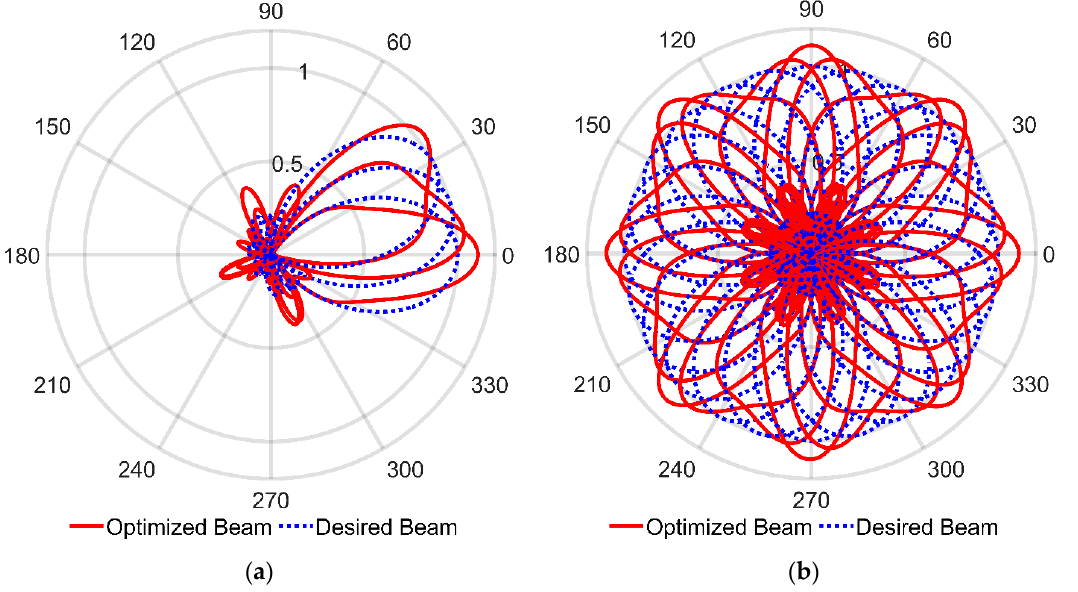
Figure 9. Beam Patterns of Regular Octagonal Configuration: ( a ) Beam to 0°, 15°, and 30°, ( b ) Rotated beams.